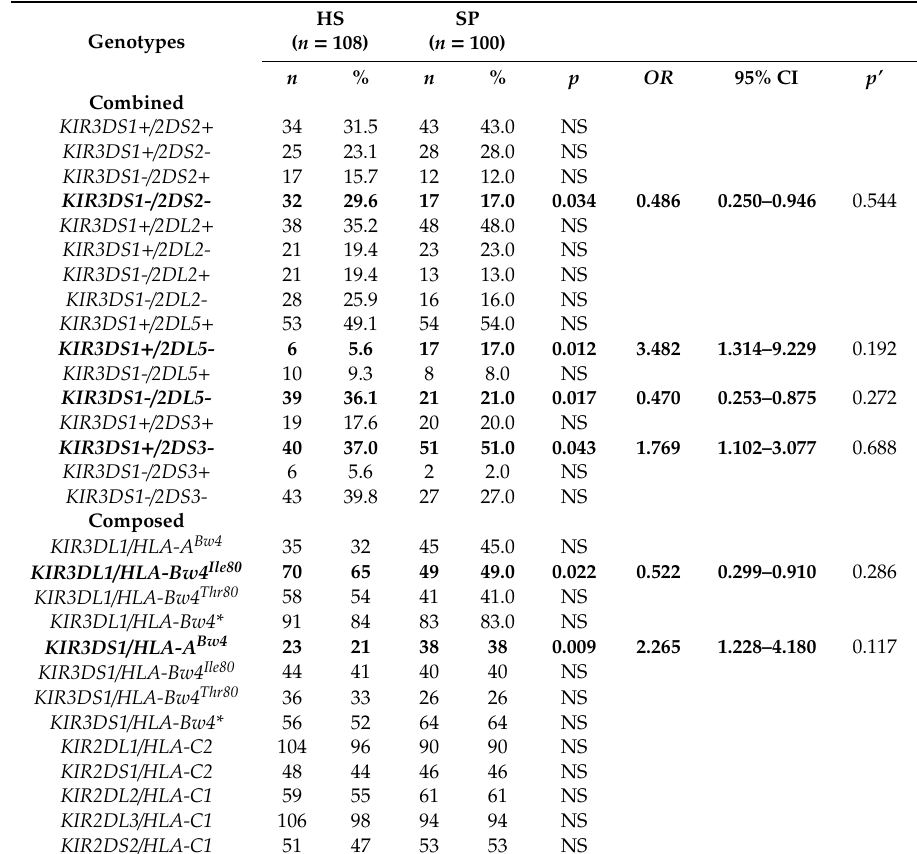
Table 3. Distributions of KIR combined and KIR / HLA composed genotypes in healthy subjects and subjects with psoriasis vulgaris.